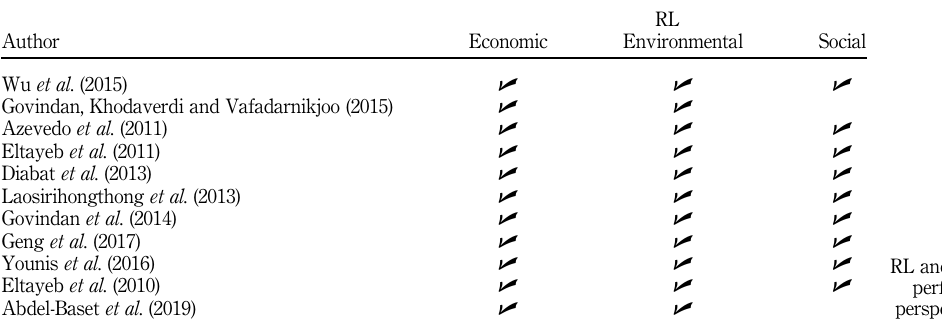
Table II. RL and